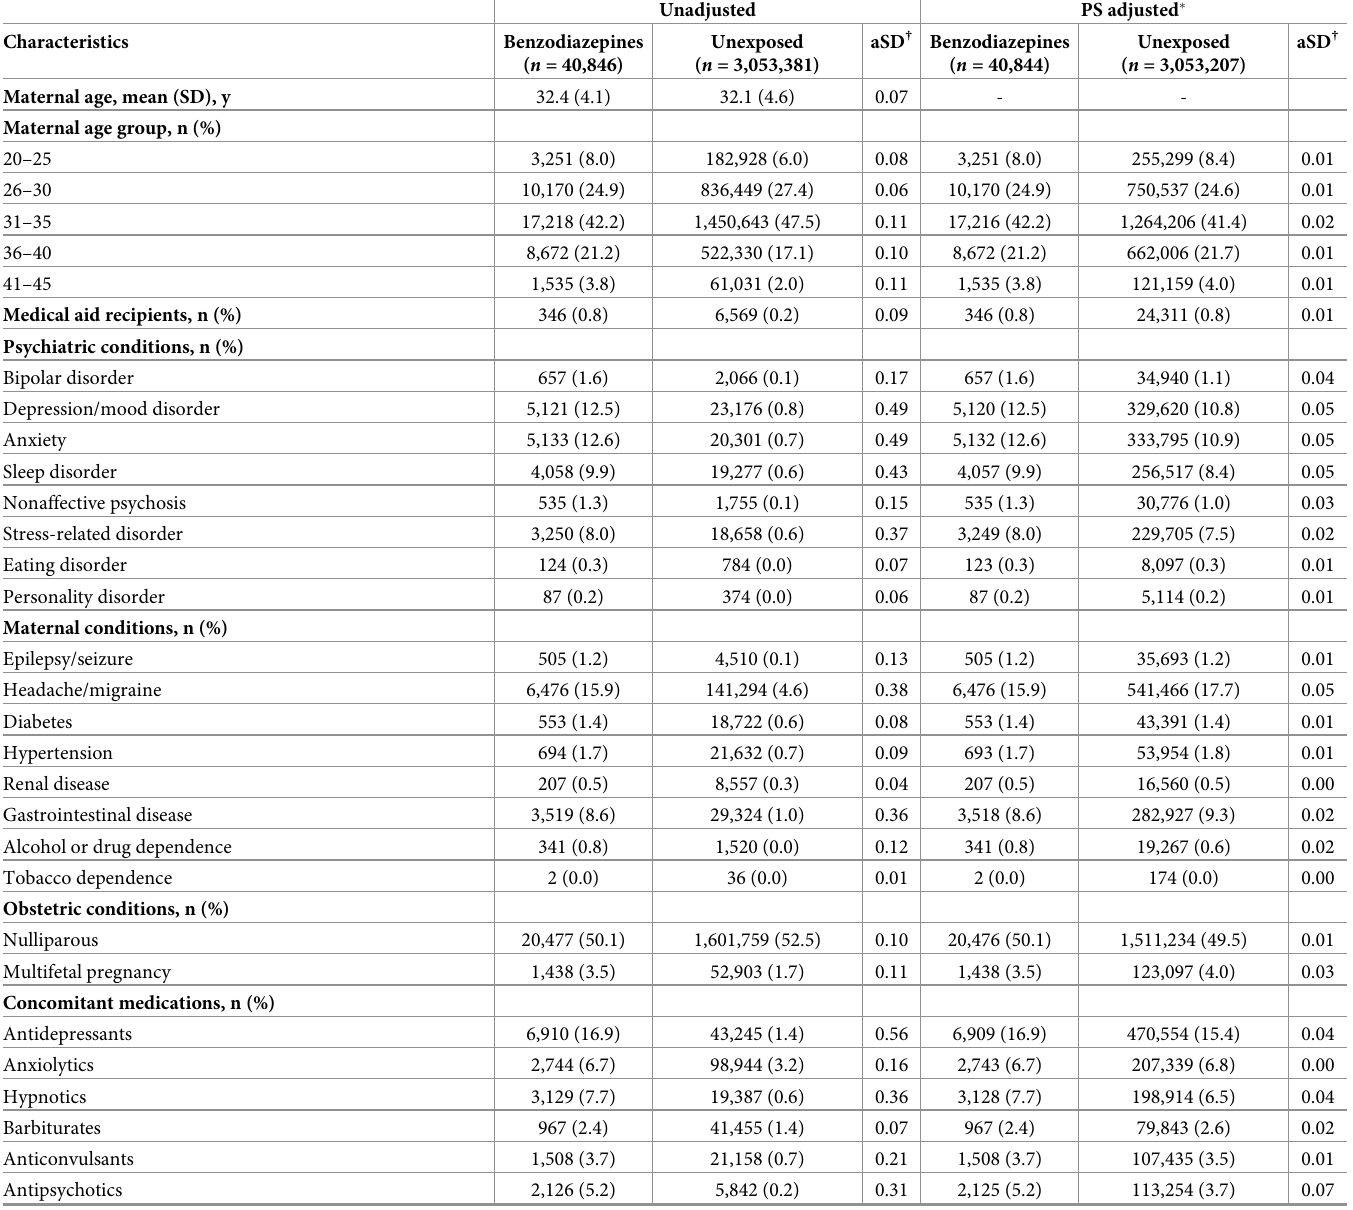
Table 1. Cohort characteristics of pregnancies with and without benzodiazepine exposure during the first